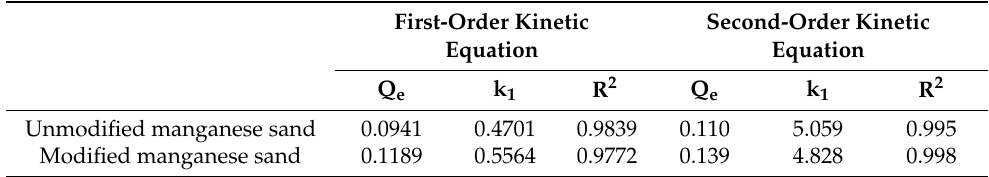
Table 5. Kinetic fitting parameters of the adsorption of iron ions by manganese sand. First-Order Kinetic Equation